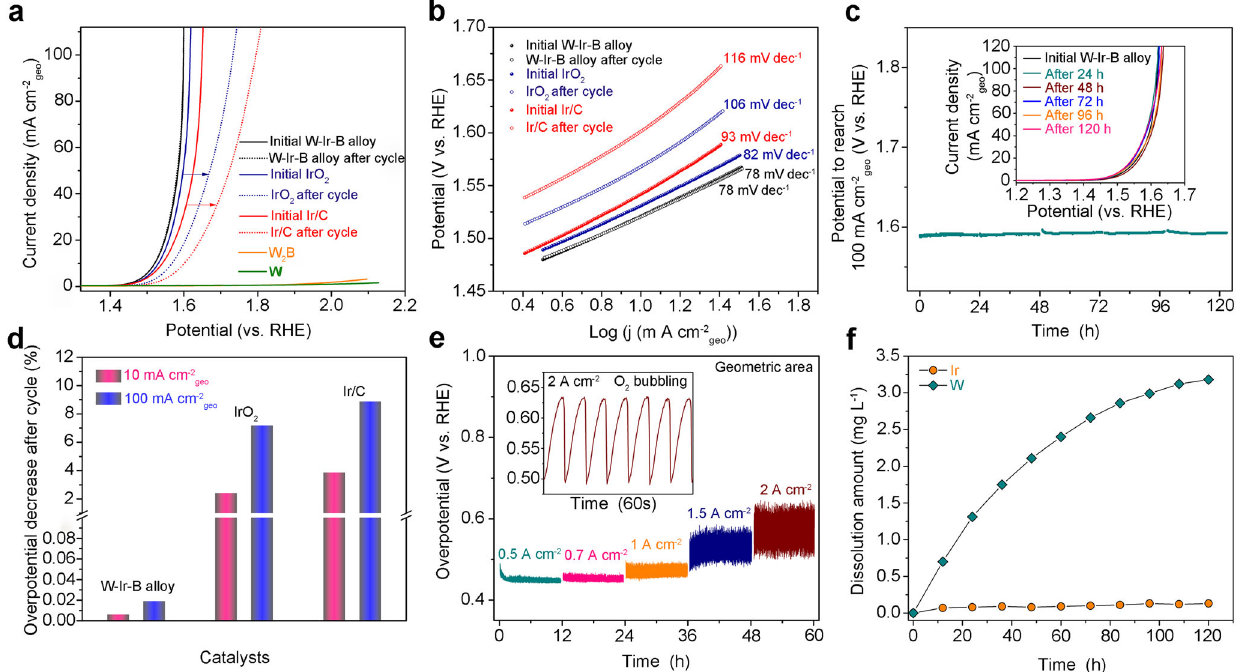
Fig. 2 OER activity and stability comparison. a Linear polarization curves of the W-Ir-B alloy, commercial IrO 2 , and Ir/C catalysts before and after 5000 cycles in 0.5 M H 2 SO 4 electrolyte. The LSV curves of the pure W and the W 2 B alloy are also included. b Tafel slopes of the electrocatalysts before and after 5000 OER cycles. c Chronopotentiometry curves of the W-Ir-B alloy catalyst in 0.5 M H 2 SO 4 electrolyte at a current density of 100 mA cm − 2 geo for 120 h. The inset shows the LSV curves taken periodically during the test (every 24h). d Activity degradations for the three catalysts at the current densities of 10 and 100 mA cm − 2 geo , respectively. e Overpotential variations of the W-Ir-B alloy catalyst at the current densities in the range of 500 mA cm − 2 geo to 2 A cm − 2 geo . The inset shows the voltage fl uctuation caused by the O 2 bubbling. f Dissolution amount variation of Ir and W elements during the 120 h acidic OER test at 100 mA cm − 2 geo